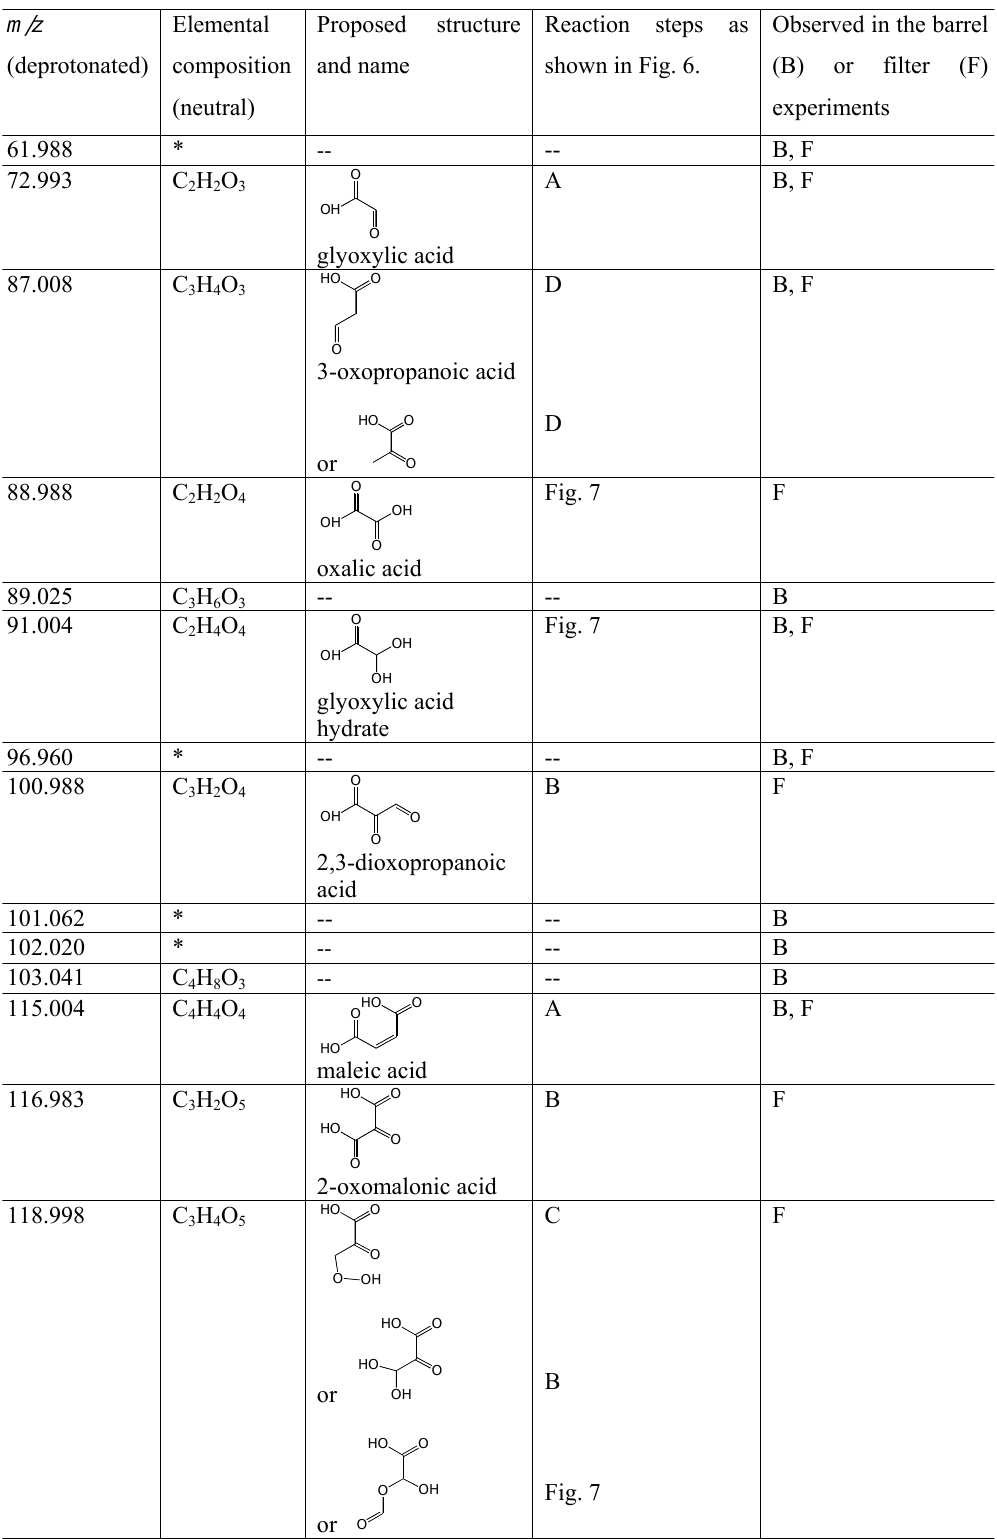
Table 1. List of peaks observed in the mass spectra from the ozonolysis of maleic acid aerosol under high RH conditions (RH > 50%) with relative peak intensities > 1%.